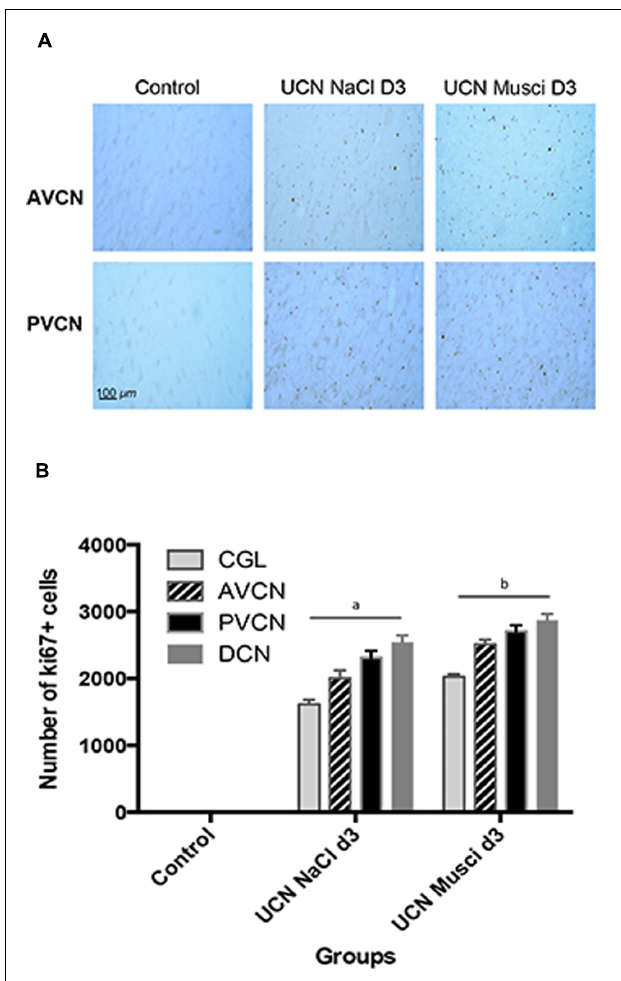
FIGURE 3 | Ki67 immunostaining was used to confirm BrdU cell proliferation. (A) Photomicrographs showing Ki67 immunostainings in the deafferented AVCN and PVCN of control cats and cats infused with NaCl or Muscimol immediately after UCN and at sacrifice (D3). Scale bar: 100 µ m. (B) Quantitative evaluation. Histograms comparing the mean values ( ± SEM) of Ki67-immunopositive cells in the deafferented CN 3 days after UCN in control cats or cats submitted to NaCl or Muscimol infusion using ANOVA followed by the Scheffé test ( p < 0.0001, see Table 2 ). Data from both sides of control animals were pooled for direct comparison with the subgroups of lesioned cats. Different letters indicate significant differences between groups of animals in each CN: a: significantly different from control and UCN Muscimol groups; b: significantly different from control and UCN NaCl groups. Only values recorded on the lesioned side are illustrated. n = 4 animals per group.